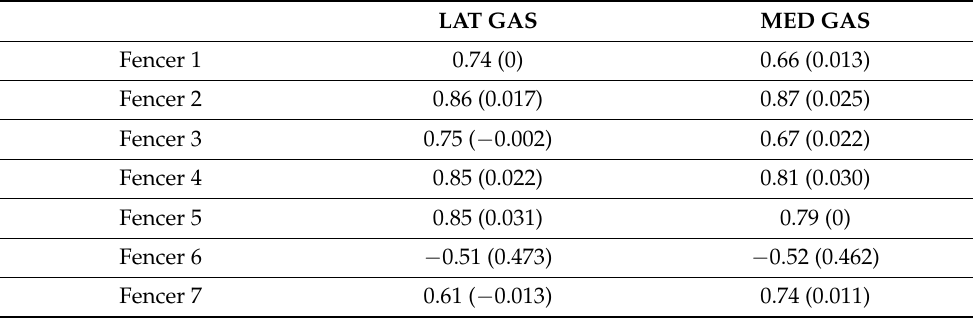
Table 2. Maximum mutual correlations of the waveforms of the rear leg forces and the EMG of the GAS muscle (in parentheses, the corresponding delay/anticipation times; positive values indicate the delay of the force in relation to EMG)